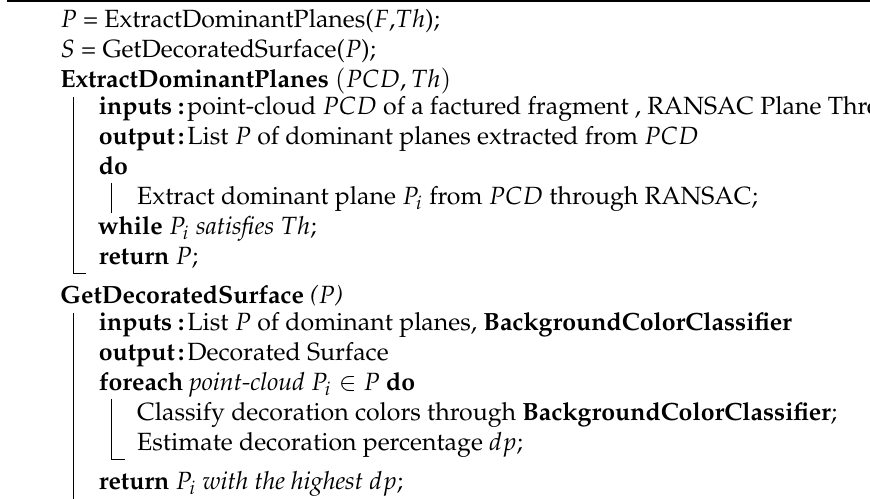
Algorithm 1: Extraction of the main decorated surface S given a fragment F and a plane threshold Th